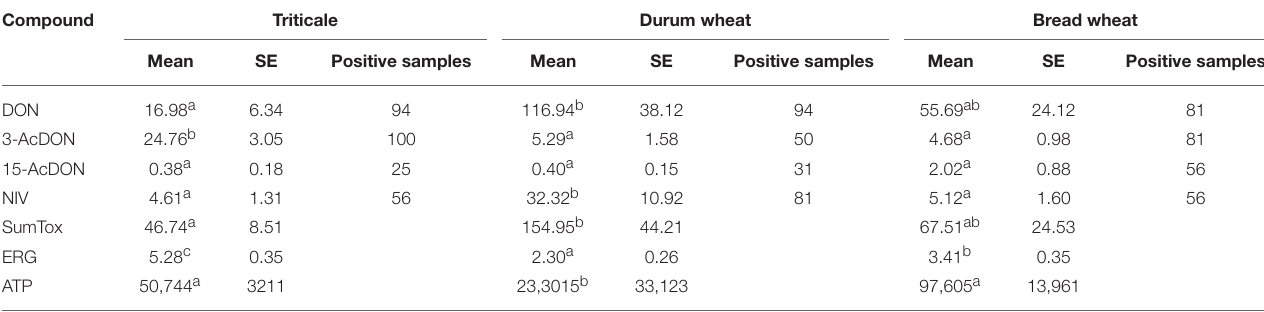
TABLE 1 | Mean concentration of trichothecenes of group B ( µ g/kg), ergosterol (mg/kg), and level of ATP (RLU) in 16 genotypes of triticale, durum wheat, and bread wheat. Compound Triticale Durum wheat Bread wheat Mean SE Positive samples Mean SE Positive samples Mean SE Positive samples DON